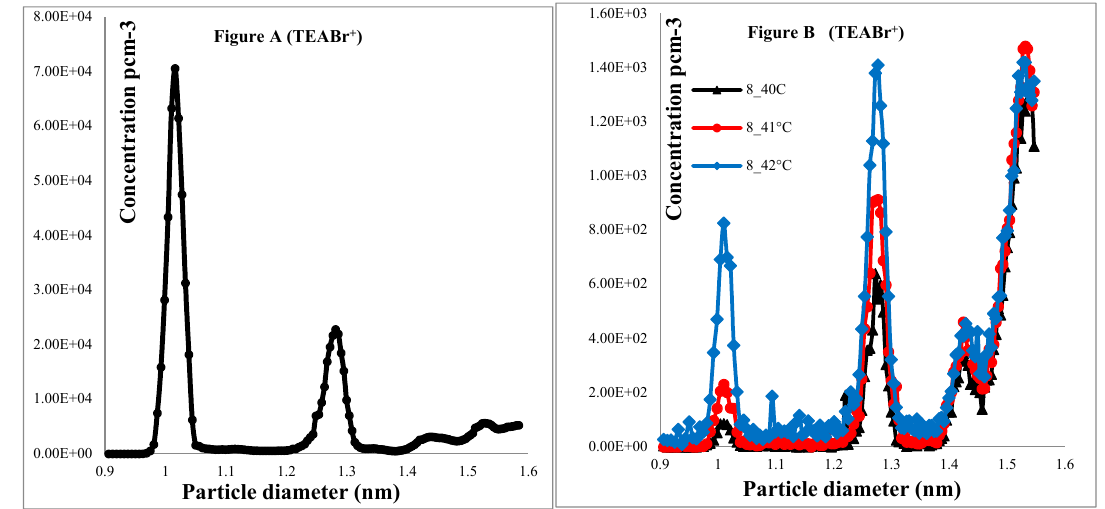
Figure 5. Mobility measurements of the tetraethylammonium bromide (TEABr) with a DMA. Aerosol electrometer was in use in the results given in the Figure A (left panel). Variable T CPC was in use for the results given in the Figure B (right panel).